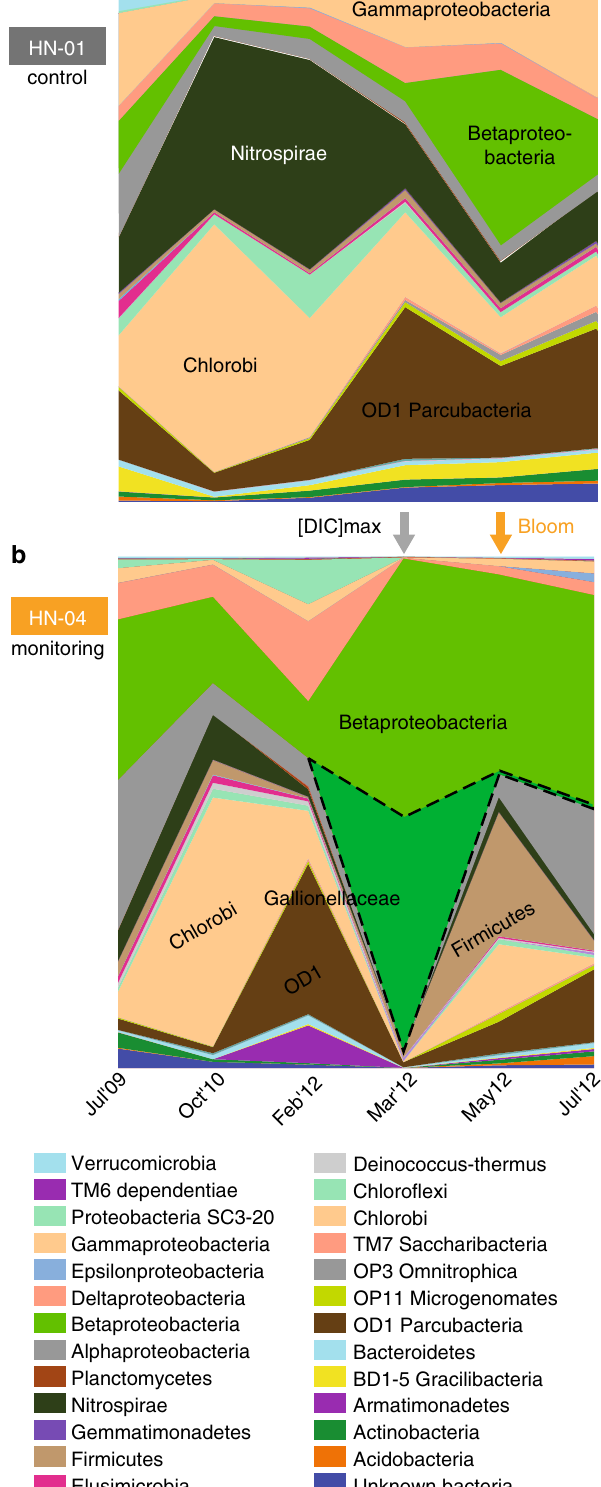
Fig. 2 Post-injection bacterial blooms based on taxonomic distribution of the 16S-rRNA gene community pro fi le obtained from 454-pyrosequencing. The post-injection bacterial blooms are represented as a function of time in the groundwater of control well HN-01 ( a ) and monitoring well HN-04 ( b ), with colors representing different taxa. Groundwater of control well HN-01 exhibited a relatively stable bacterial community with Chlorobi, Nitrospirae, OD1 Parcubacteria and Proteobacteria as dominant community